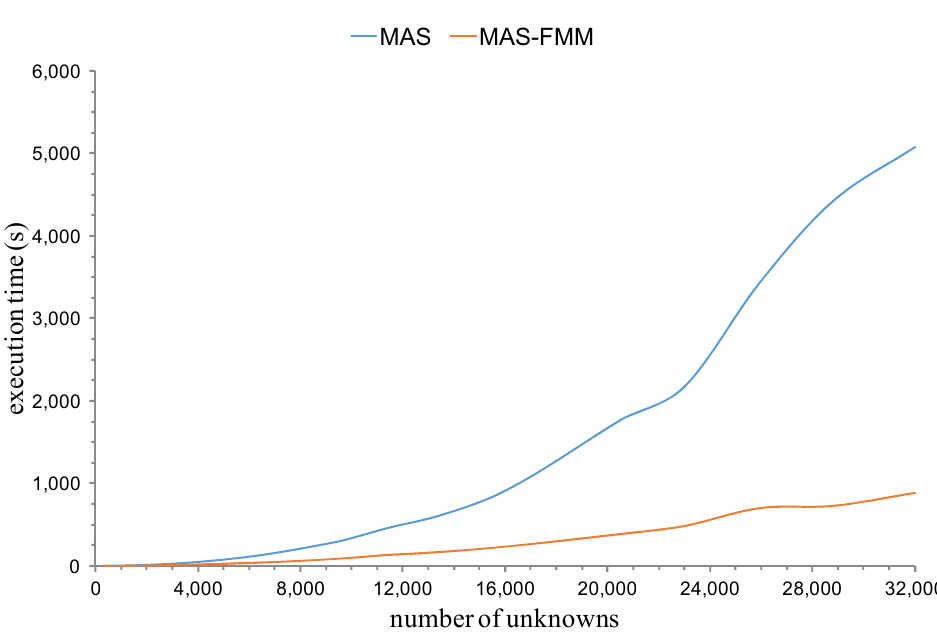
Figure 5. RCS (in dBm) as a function of the observation angle in the azimuth plane for a 1 × 5 lattice of cylinders. The parameters pertaining to the cylinders and the incident field are provided in Table 1. The rhombic dots correspond to the forward and backward RCS tabulated in [29], and to certain other RCS values estimated from [29].